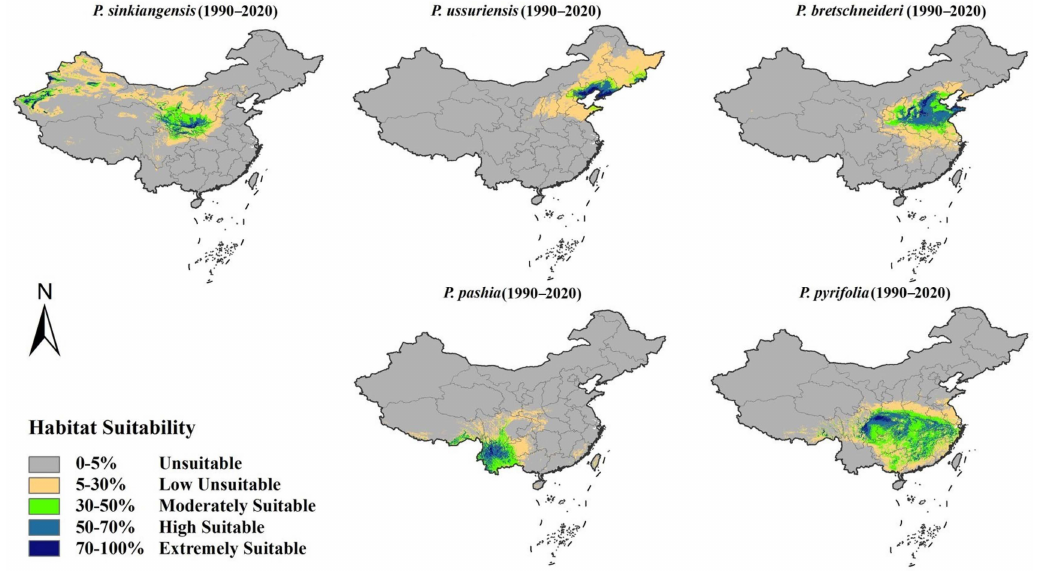
Figure 3. Suitable planting regions for different species of Pyrus under current climate conditions